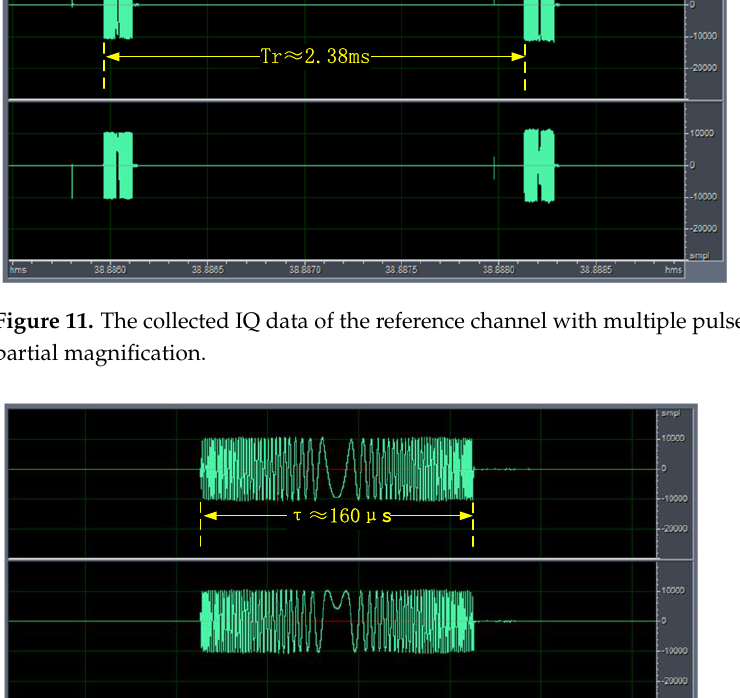
Figure 12. The collected IQ data of the reference channel with single direct wave pulse after partial